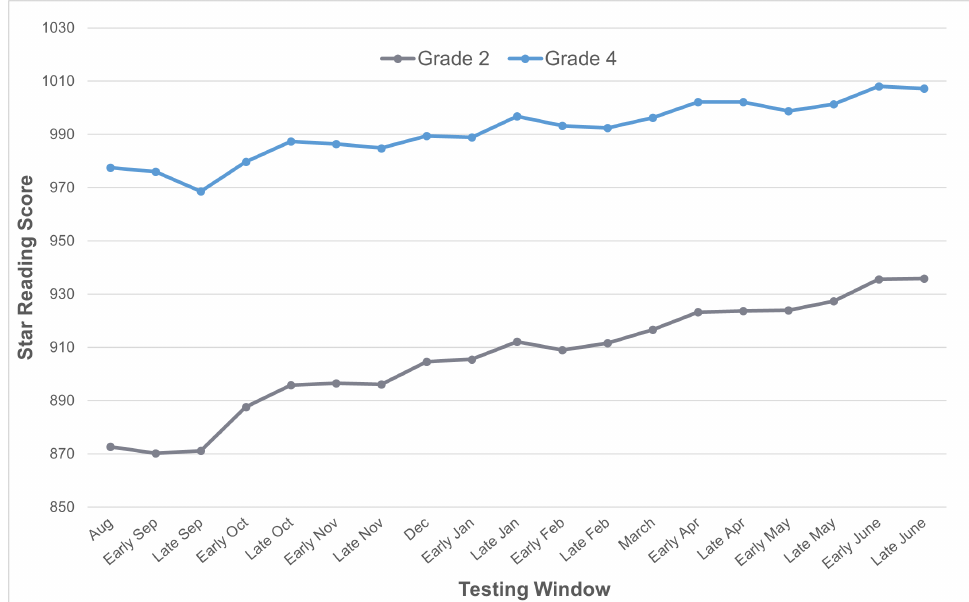
Figure 4. The average Star Reading scores in each test